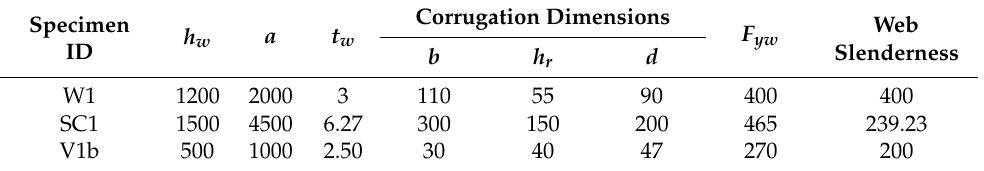
Table A9. Test data reported by Wang et al. [30], Sause [8] and Hannebauer [31].